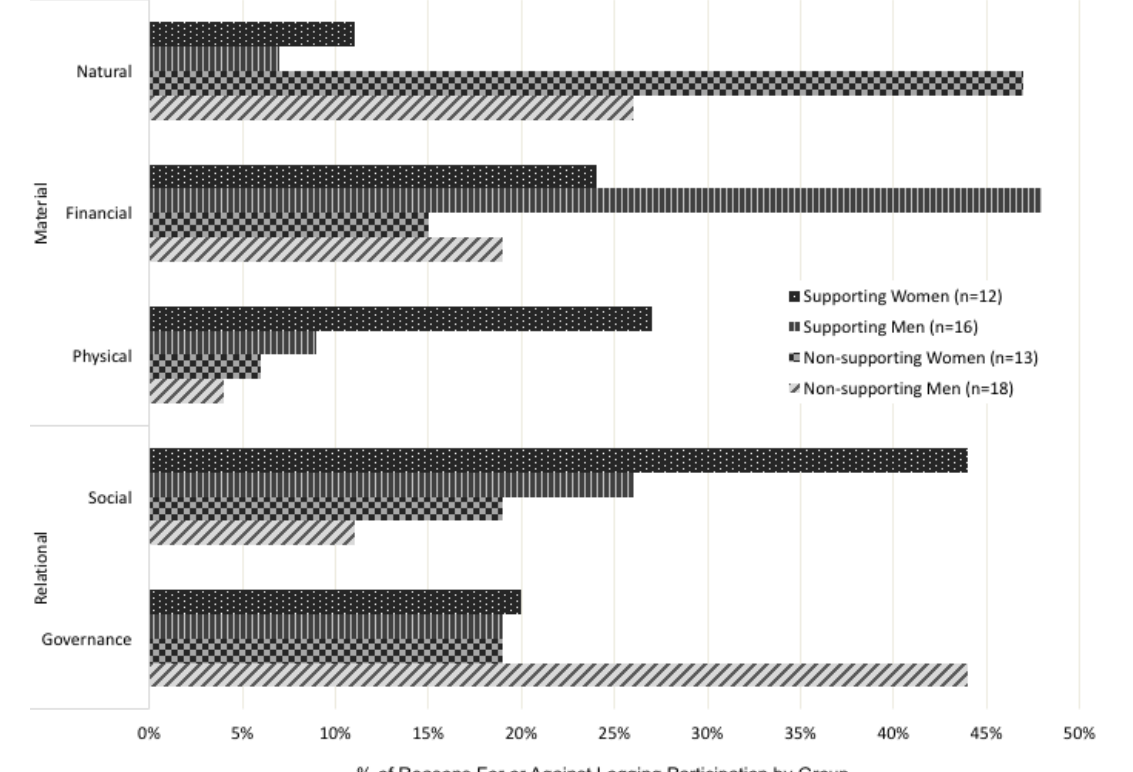
Fig. 4. Reasons for and against logging project participation among residents of Chico Mendes Extractive Reserve were divided into five categories and compared by resident support and